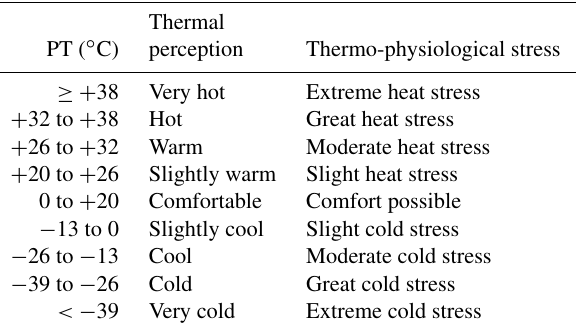
Table 1. The thermo-physiological meaning of PT results for central Europe as defined by Staiger et al.